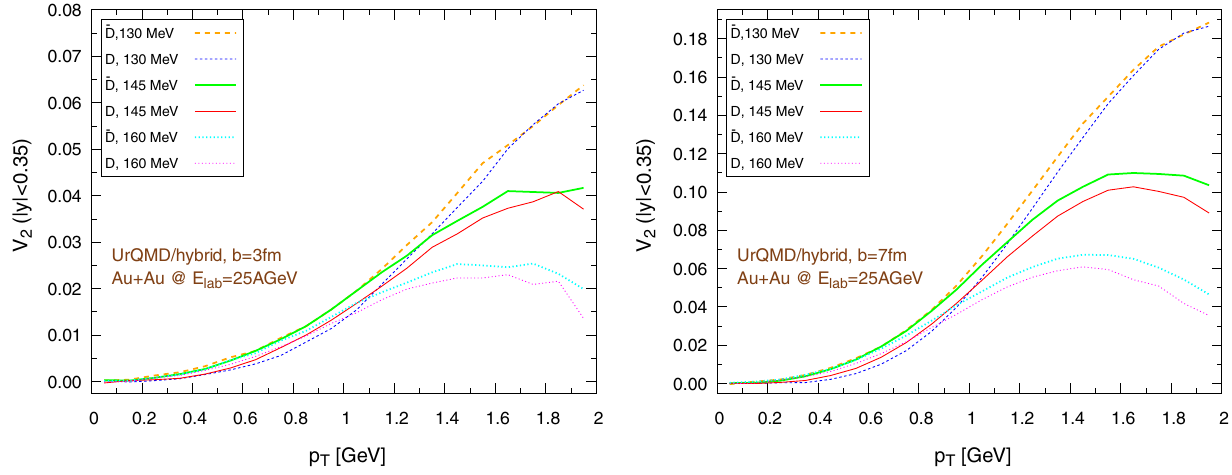
Fig. 18 Elliptic flow of D / ¯ D mesons ( | y | < 0 . 35) within the UrQMD/hybrid approach in Au+Au collisions at E lab = 25 AGeV. We show different hadronization temperatures, with fixed parameters: (cid:23) p = 0 . 05 and the ordinate.)